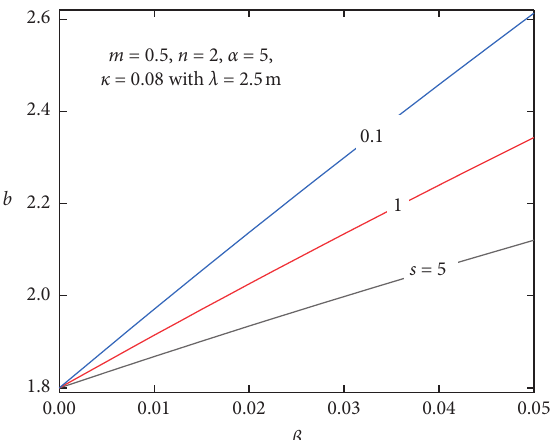
Figure 9: Stress field in the cross-section of piles, for different friction ratios s .